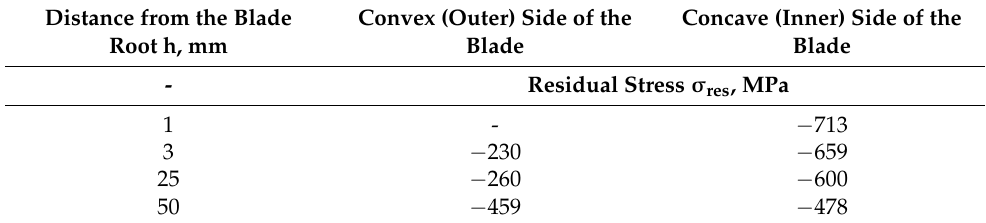
Table 1. Results of the residual/initial stress measurements on the blade surface. Distance from the Blade